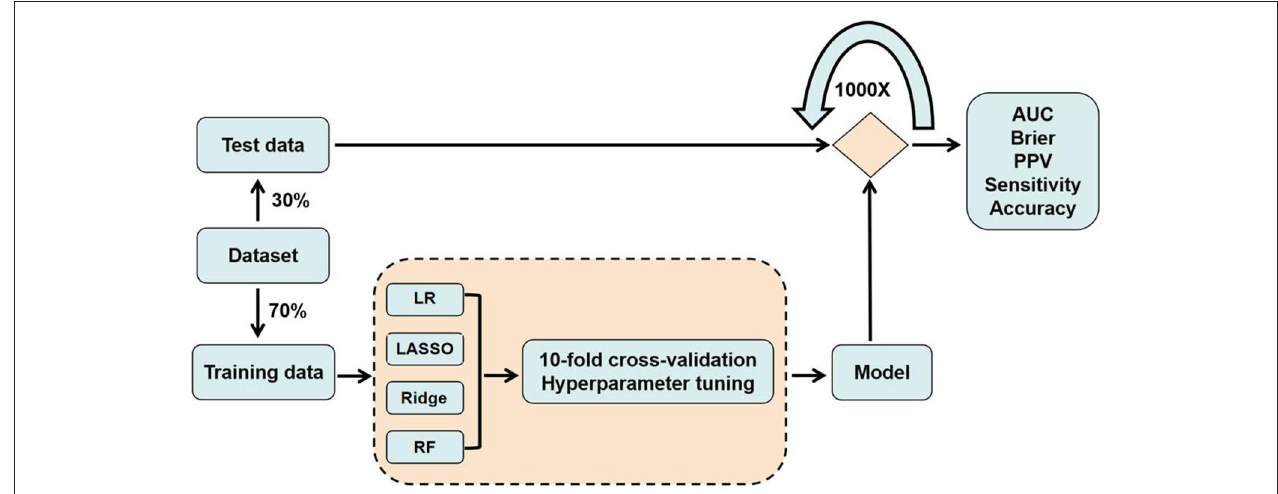
FIGURE 1 | Model procedure for training and testing data.